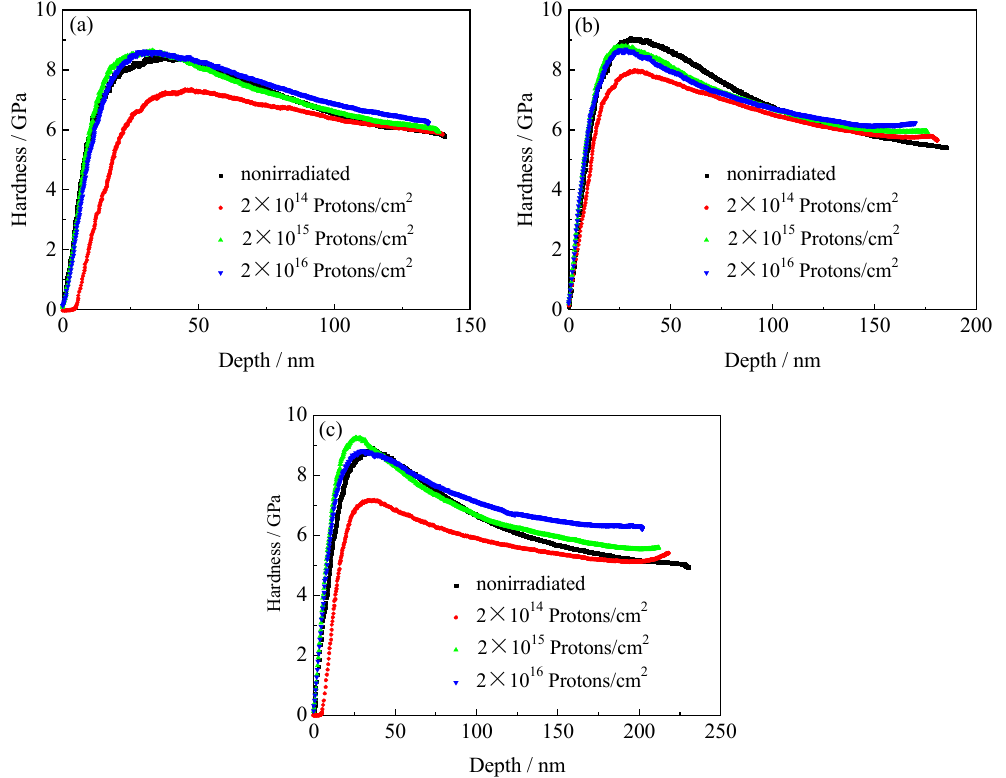
Figure 12. Variation of indentation hardness of tempered 5140 alloy steel tempered at 520 °C with depth under different loads before and after proton irradiation: ( a ) 4000 µN, ( b ) 6000 µN, ( c ) 8000 µN.